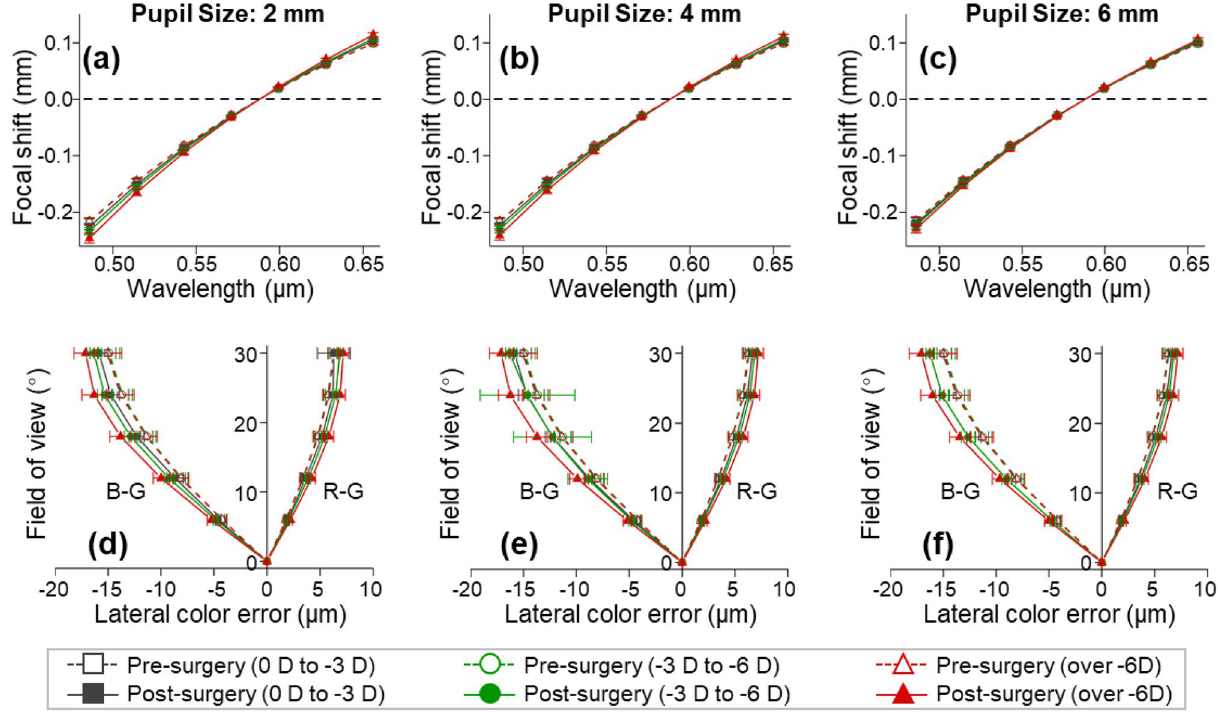
Figure 3. Chromatic aberration analysis (mean ± SD) at retina before and after femto-LASIK. R: red light, 656.273 nm; G: green light, 587.562 nm; B: blue light, 486.133 nm. ( a – c ) show the longitudinal chromatic focal shifts relative to green light (587.562 nm) at 2-mm, 4-mm, and 6-mm pupil sizes, respectively. ( d – f ) show the transverse chromatic aberrations across the field of view (0°–30°) at 2-mm, 4-mm, and 6-mm pupil sizes, respectively.